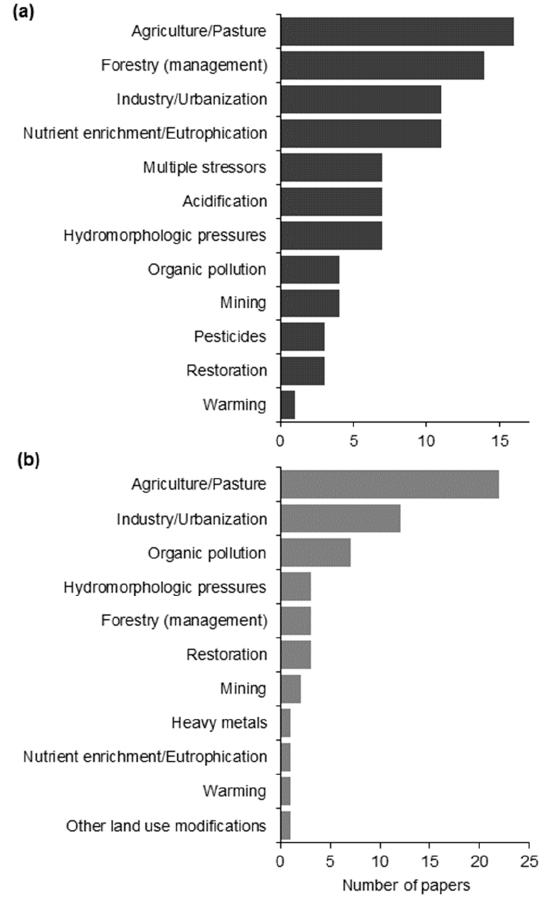
Figure 4. Types of environmental change addressed in bioassessment studies using ( a ) organic matter decomposition ( n = 75) or ( b ) ecosystem metabolism ( n = 43). Several studies addressed multiple environmental changes and so the sum of the studies across types surpasses the number of bioassessment studies.